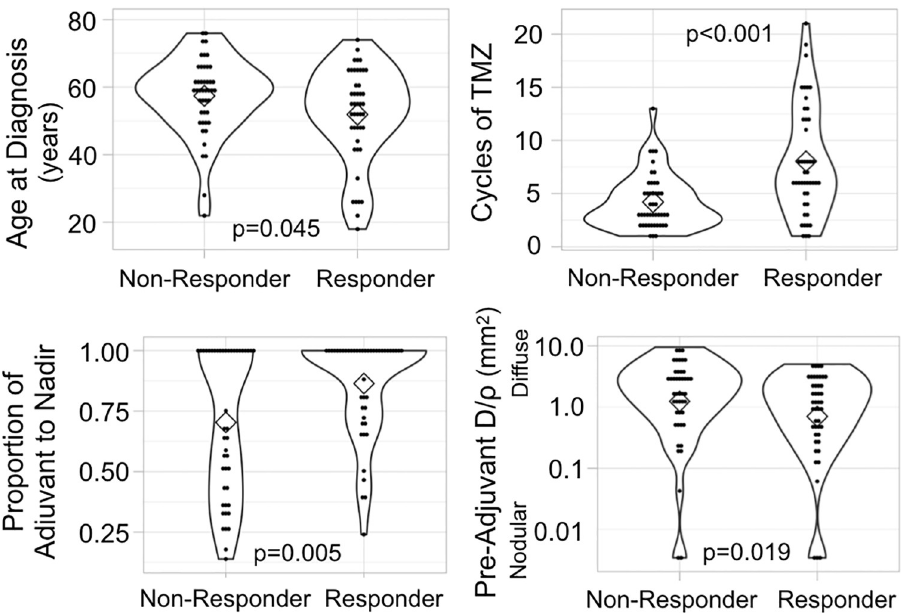
Fig 1. Characteristic differences between responders (n = 45) and non-responders (n = 45). Statistical tests (t-tests) show that volumetric responders (decrease in T1Gd volume during adjuvant TMZ) were younger, received more cycles of TMZ, reached nadir relatively later during adjuvant therapy, and had more nodular tumors than non- responders (increase in T1Gd volume during adjuvant TMZ). Proportion of adjuvant to nadir is calculated as the number of days between pre-adjuvant and nadir images divided by the total number of days between pre-adjuvant and post-adjuvant images. (Black dots in the violin plots indicate individual subject values, diamonds indicate median values, and outline denotes